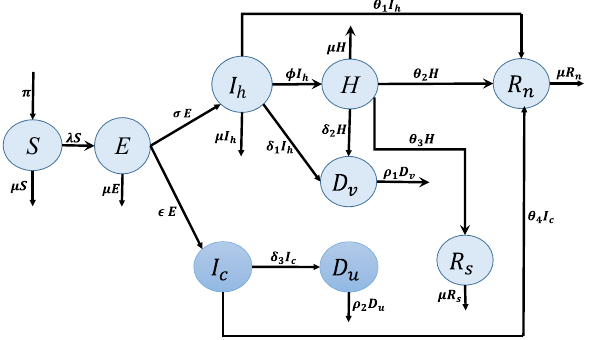
Figure 1. The model diagram for EVD.